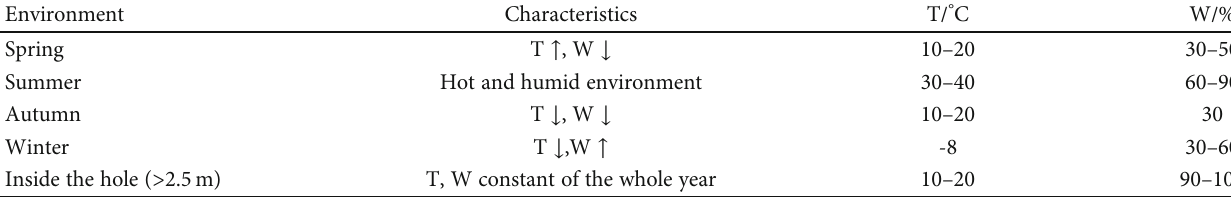
Table 4: Design of environmental parameters of aqueous gaseous water adsorption.